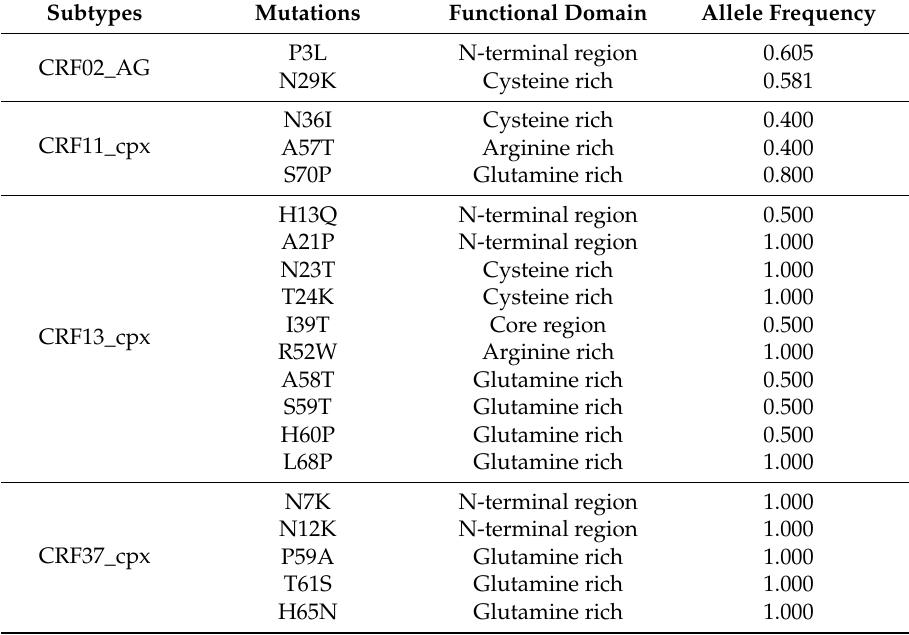
Table 2. Mutations in Tat exon-1 of Cameroon HIV-1 isolates.